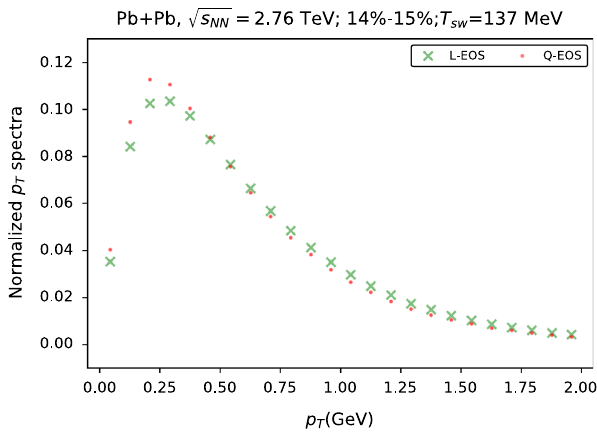
greencrossandtheredpointsymboldepicttheobservableswithL-EOS and Q-EOS, respectively. These events are generated in centrality bin